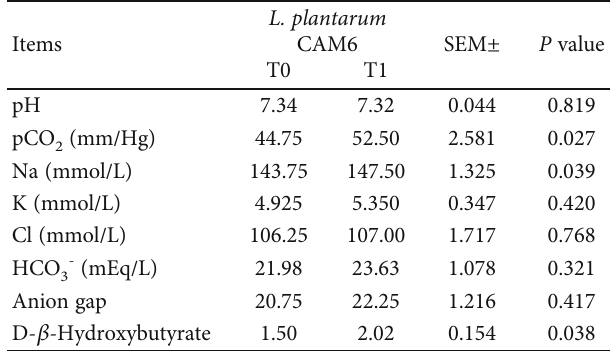
Figure 2: Derived impact of Lactobacillus plantarum CAM6 supplementation for sows to their progeny performance: (a) the derived impact of the probiotic supplementation for sows to the body weight of their progeny and (b) the derived impact of the probiotic supplementation for sows to reducing the diarrhea incidence (DI) of their progeny. T0: basal diet (BD); T1: BD + 10 mL biological agent containing 10 9 CFU/mL L. plantarum CAM6. ∗ P ≦ 0 : 05 . Table 3: The derived in fl uence of Lactobacillus plantarum CAM6 supplementation in sows ’ feeding on the BAS and serum BHB of the lactating piglets (28 days of